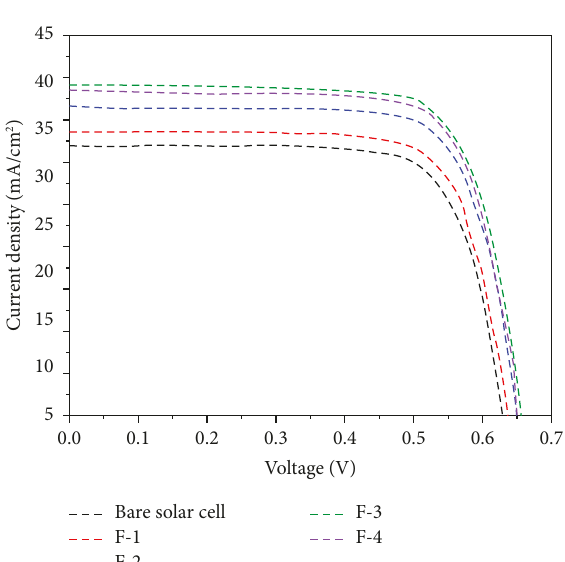
Figure 8: The outcome of photogeneration of various coated FeS